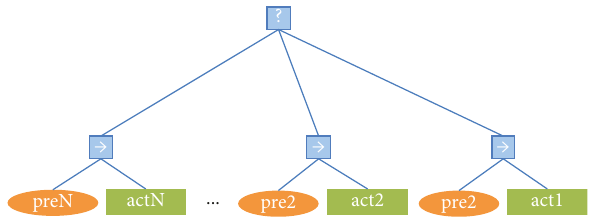
Figure 7: Representation of a robust logical-dynamical chain